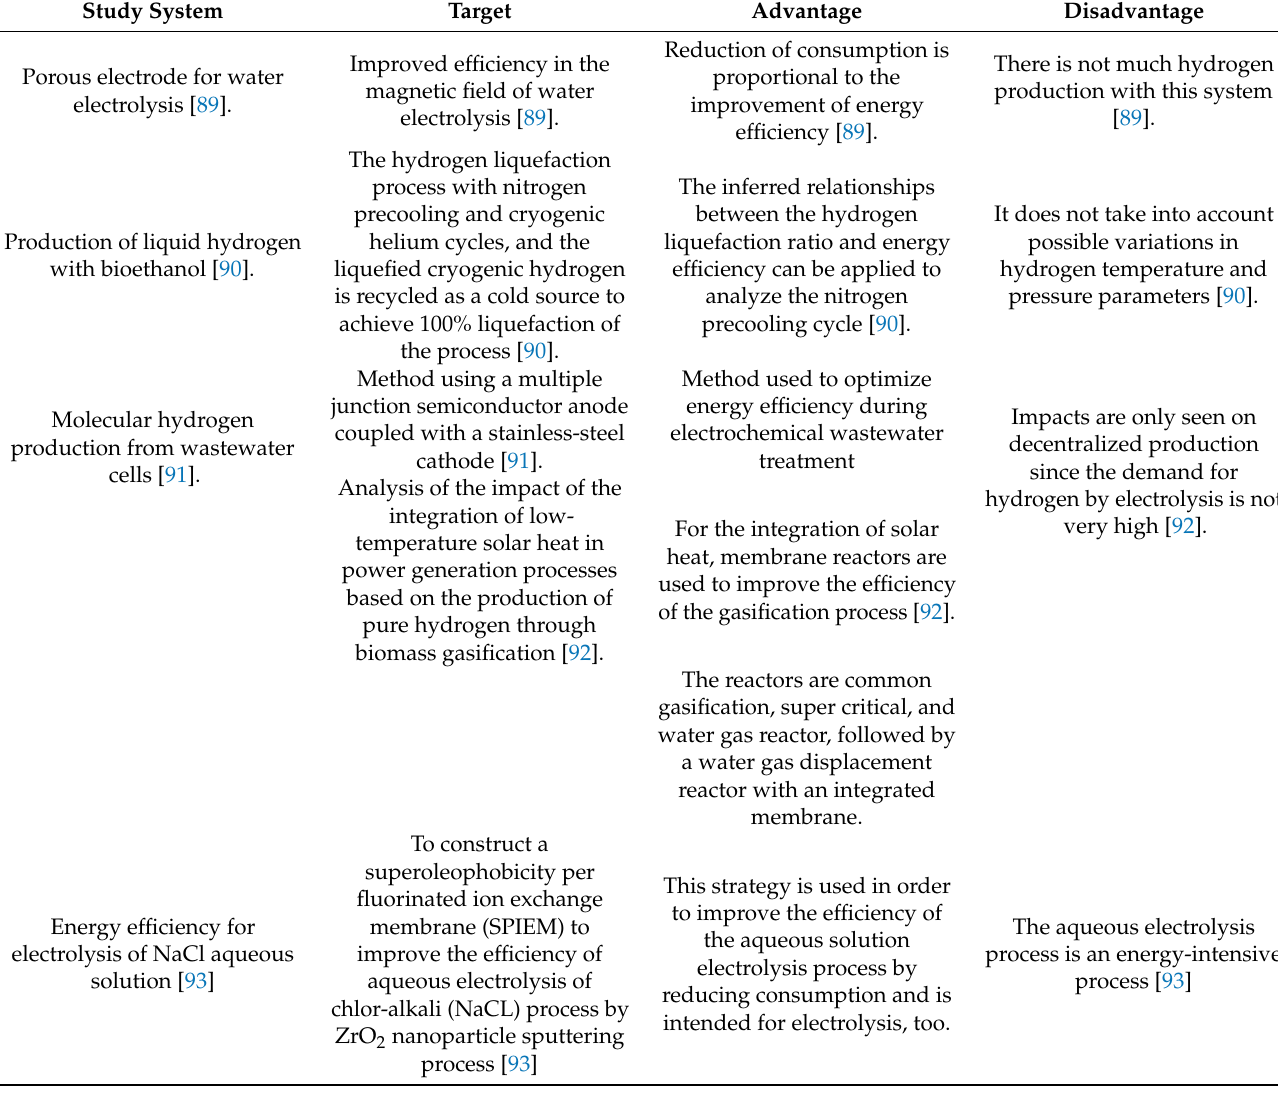
Table 10. Energy